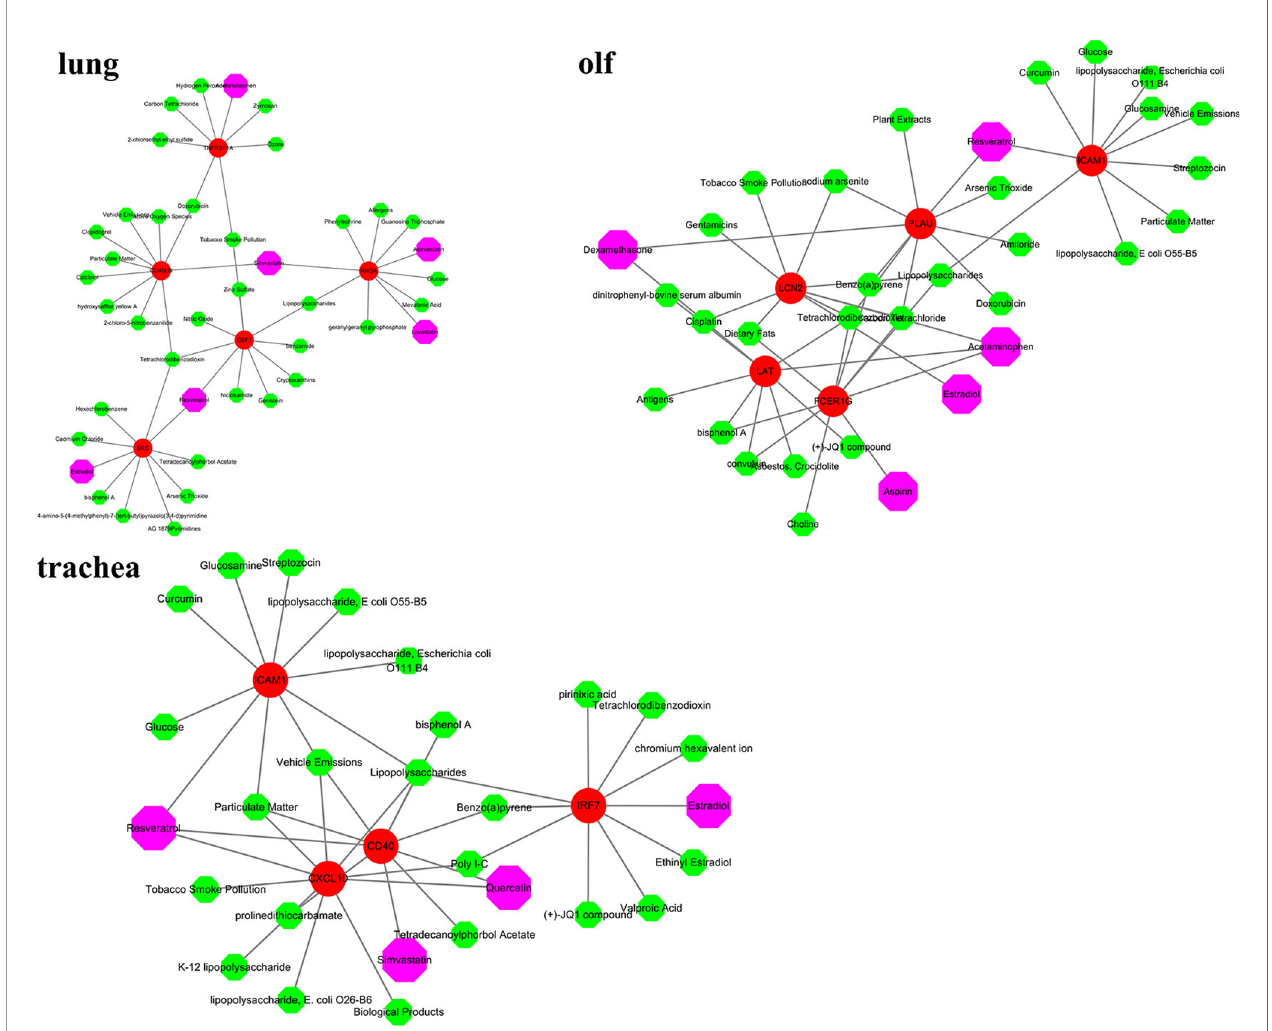
FIGURE 7 | Screening of potential therapeutic drugs for different organ dysfunctions. Red indicates hub genes of organs, whereas purple indicates potential therapeutic drugs that target hub